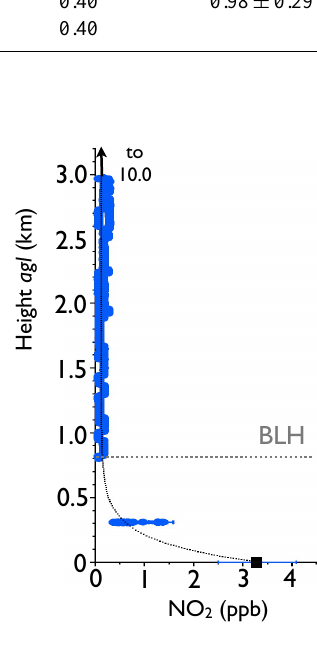
Fig. 8. The NO 2 concentration profile used to construct the compos- ite NO 2 VCDs on 26 June 2007. Blue circles represent NO 2 aircraft measurements, while the black square represents the ground-based NO 2 by active DOAS. The boundary layer (BLH) is marked with the horizontal dashed